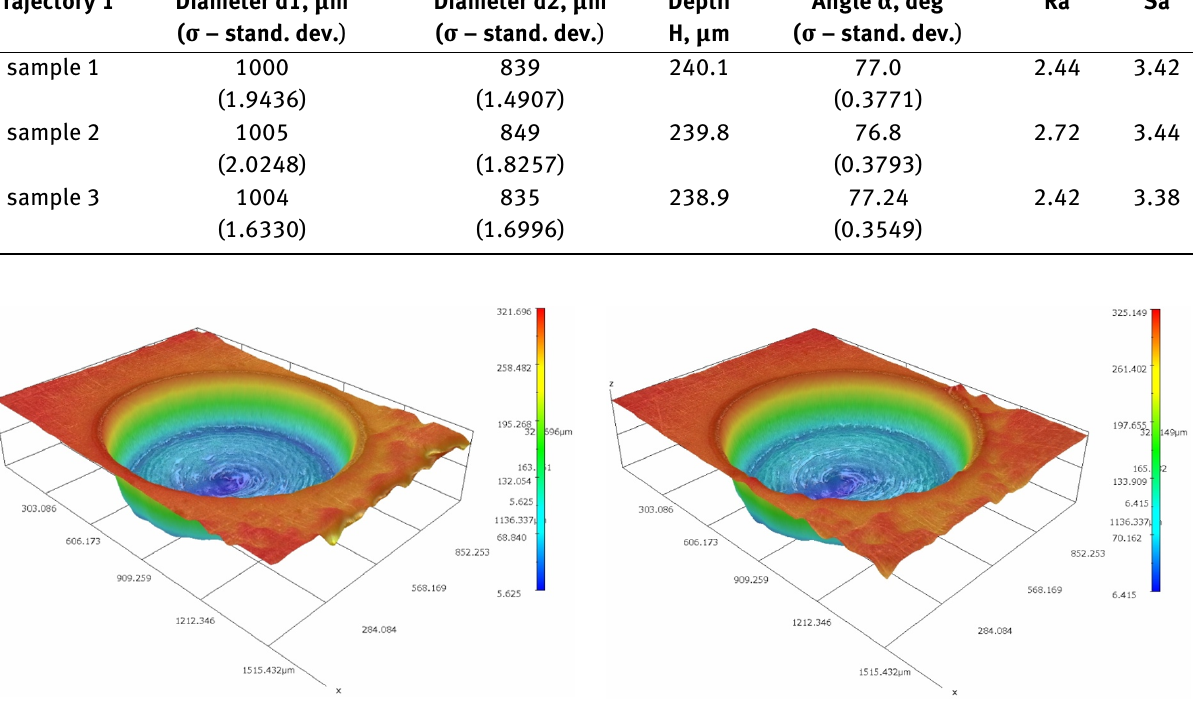
Figure 8: 3D profile of the second sample for trajectory No. 2.